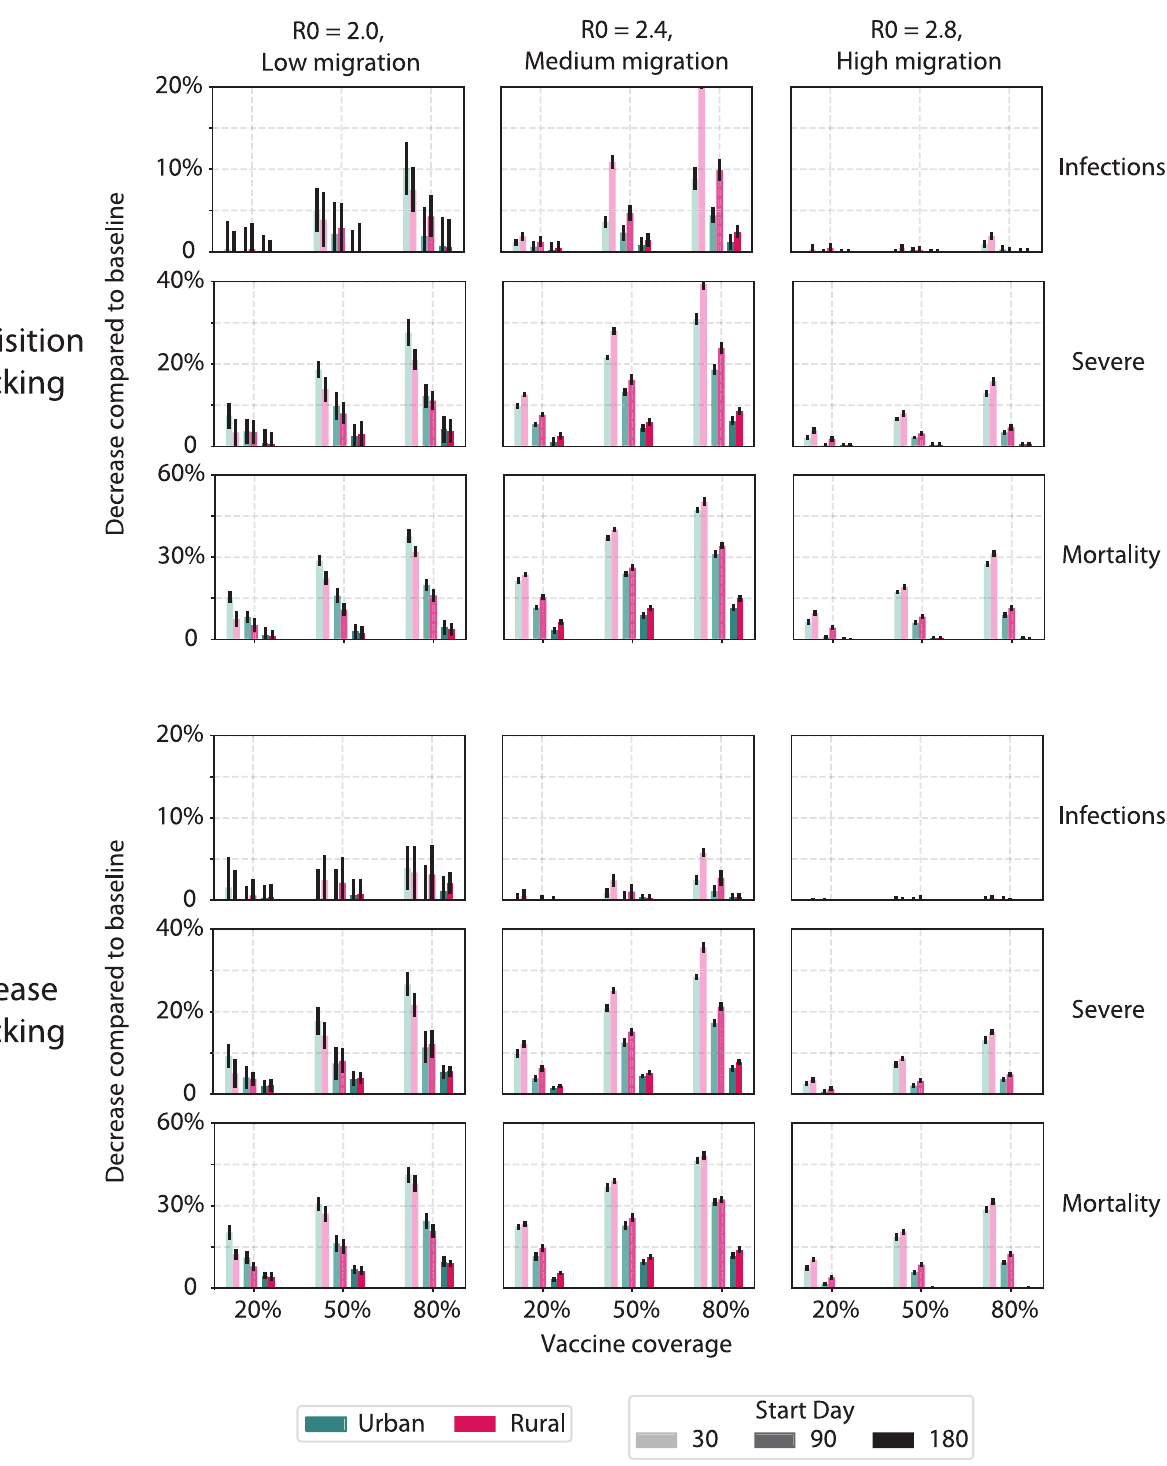
Fig 10. Vaccination campaign impact on infections, severe cases and deaths by spatial (urban-rural) prioritization. Bars indicate mean reduction in respective cumulative indicator, and error bars indicate standard error.